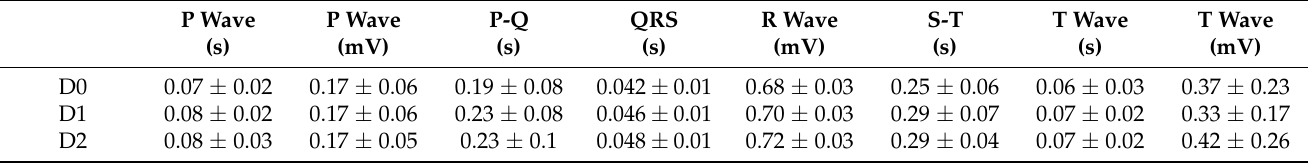
Table 2. Duration and amplitude of P waves, the QRS complex, and their segments and/or intervals. P